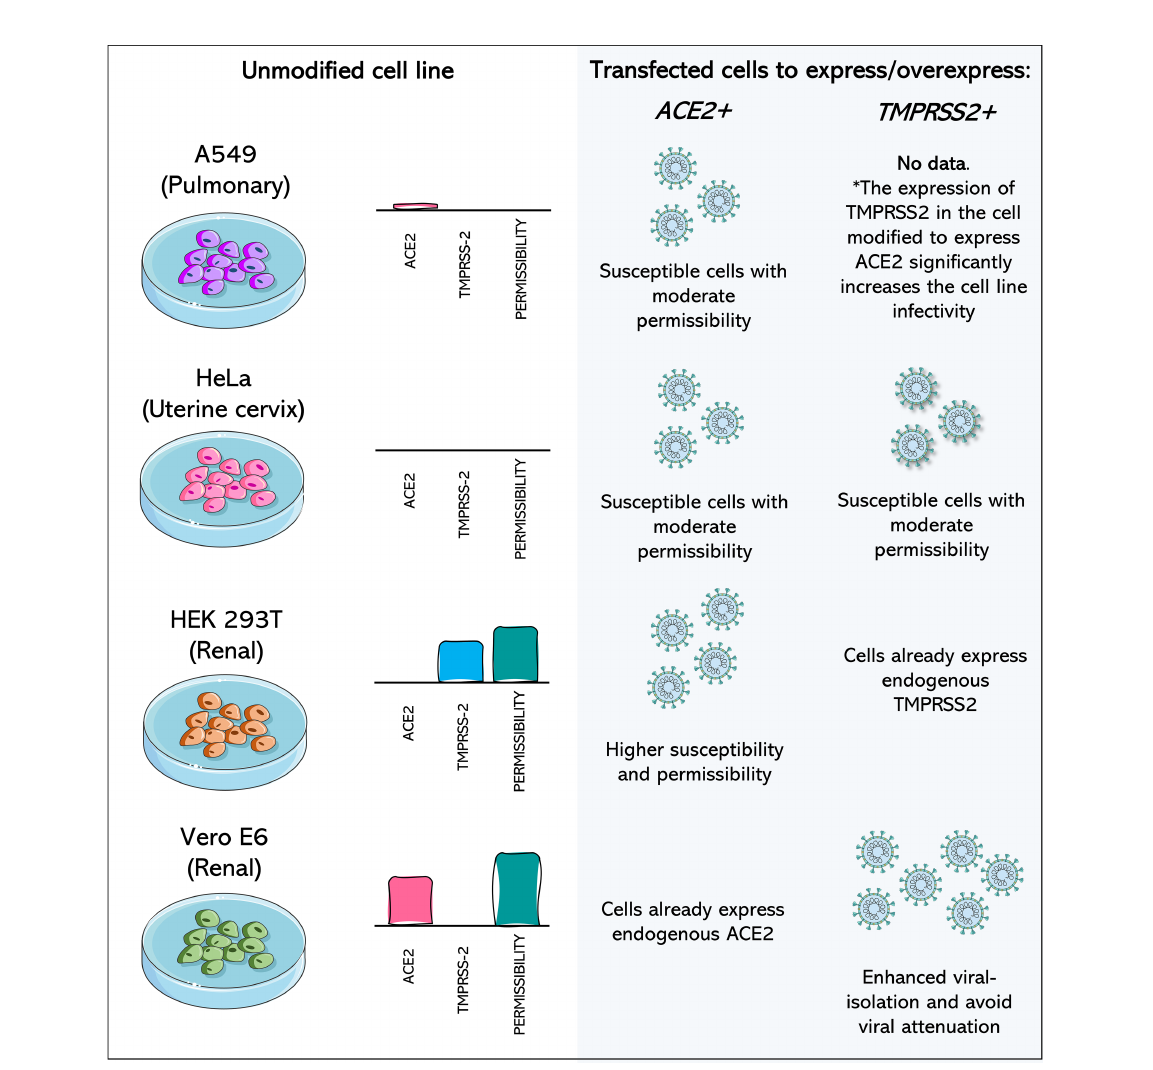
FIGURE 3 Cell lines transfected to express or overexpress ACE2 and TMPRSS2 show increased isolation of, susceptibility to, and permissibility for SARS- CoV-2. A549 (Pulmonary) cell line has poor expression of ACE2 and no expression of TMPRSS2, being considered a non-permissive cell to SARS-CoV-2. When ACE2 or both components are expressed after transfection of the cell, it becomes moderately permissive and susceptible to SARS-CoV-2. HeLa cells (Uterine cervix) are not susceptible to SARS-CoV-2 infection, as they do not express the viral receptors. Transfection of ACE2 and TMPRSS2 leads to susceptibility and moderate permissibility. In susceptible cells, such as Vero E6 monkey cells and HEK 293T and human renal cells, transfection with the receptor which they do not express endogenously leads to greater cell permeability. Vero E6/TMPRSS2 + cells have higher rates of SARS-CoV-2 isolation and potentially prevent attenuation of the virus. Data concerning the expression pro fi le of each cell were recovered from Vectorbuilder; Murgolo et al., 2021; Saccon et al., 2021; Shuai et al., 2020 and Hoffmann et al., 2020. The asterisk (*) draws attention to the fact that no data was found about the impact of the expression of only TMPRSS2 in A549 cells, but the combination of TMPRSS2 expression in A549 cells already modi fi ed to overexpress ACE2 leads to increased